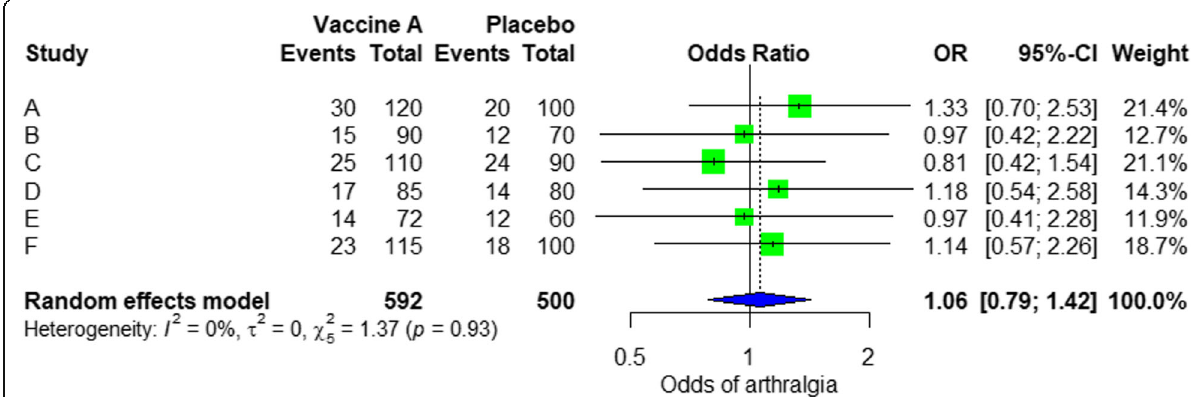
Fig. 3 Random effect model forest plot for comparison of vaccine A versus placebo